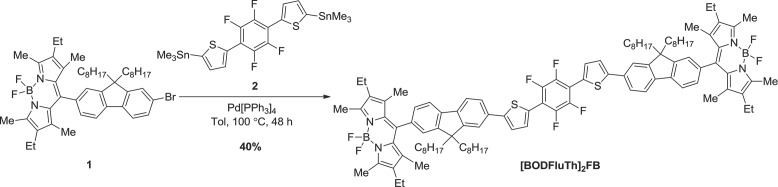
SchemeSynthesis of [BODFluTh]2FB.